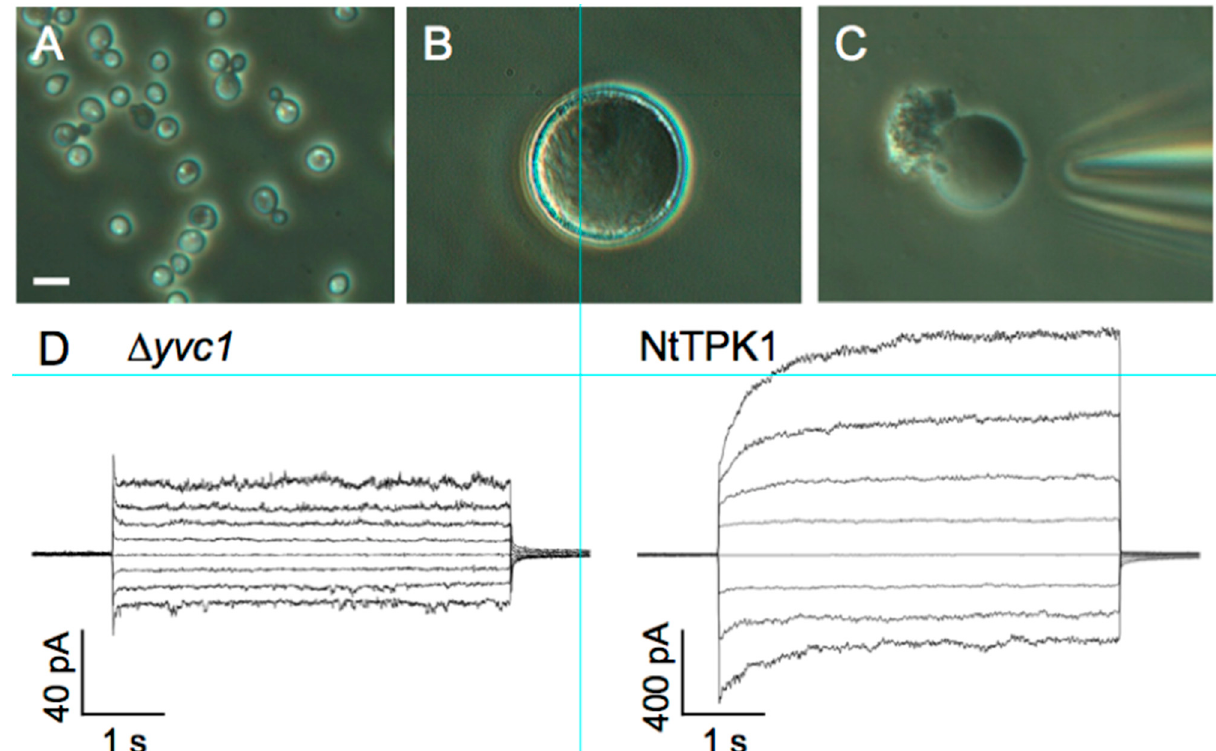
Figure 7. “Yeast Vacuoles”: The whole vacuole patch clamp recording of a giant yeast. ( A – C ) Haploid yeast ( S. cerevisiae ) was enlarged to giant yeast, and exposed vacuole with patch pipette. Bar = 5 µ m. ( D ) Representative profile of whole vacuole currents elicited by a series of voltage steps ranging from − 60 to 80 mV in 20 mV steps of the ∆ yvc1 strain (left) and the NtTPK1-expressing cells (right).